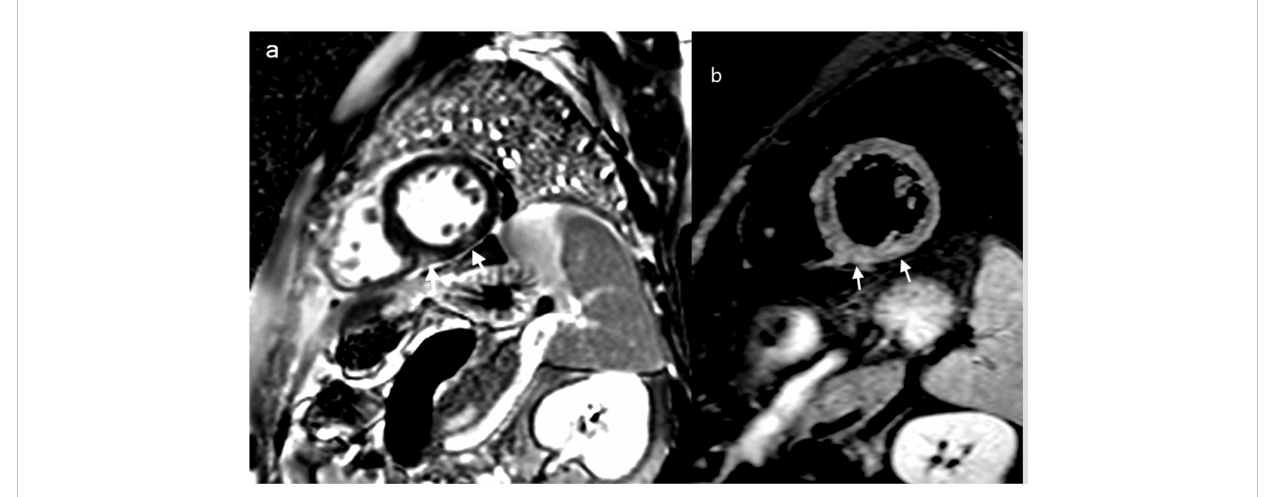
FIGURE 2 Cardiac MRI: delayed MRI enhancement sequence using the short-axis (A) highlights two contrast upateks with mid-myocardial and sub-epicardial topography at the level of the infero-septal and inferior wall of the left ventricle (white arrows) which correspond to focal ares of mycocardial edema visible in T2 weighted image with fats saturation (B) white arrows, suggesting acute